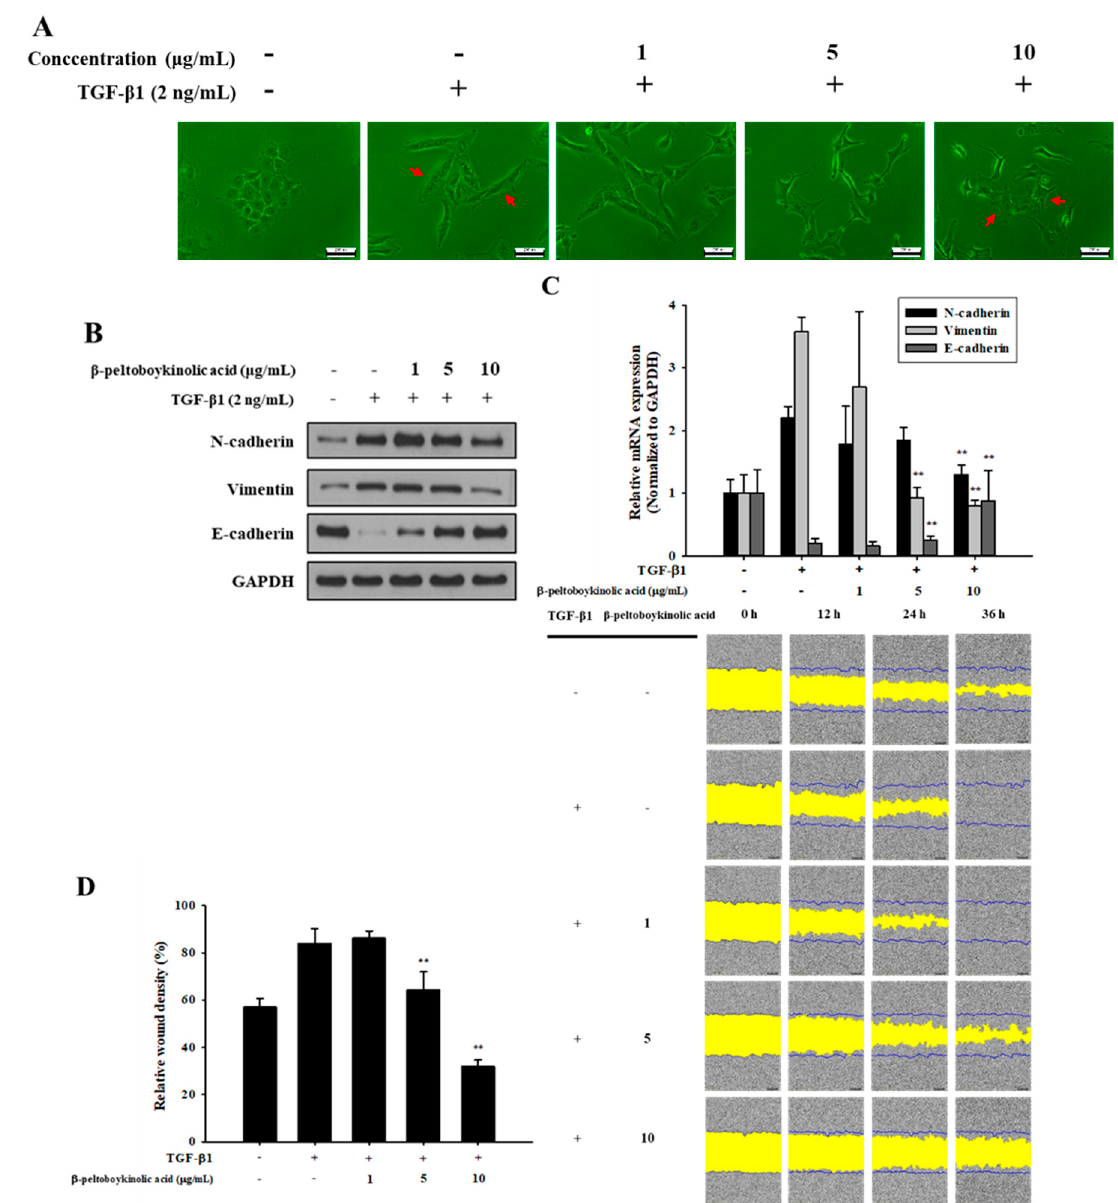
Figure 4. Inhibitory effect of β -peltoboykinolic acid on TGF- β 1-induced epithelial-to-mesenchymal (EMT) in A549 cells. A549 cells were treated with TGF- β 1 or co-treated with β -peltoboykinolic acid for 48 h. ( A ) The morphology of A549 cells was observed using a phase-contrast microscope. Arrows indicate the difference between cell morphologies. Scale bar = 200 μ m. ( B ) The expression of N-cadherin, vimentin, and E-cadherin proteins were analyzed using Western blot analysis, with GAPDH expression used as a loading control. ( C ) A549 cells were treated with TGF- β 1 (2 ng/mL) or co-treated with β -peltoboykinolic acid (1, 5, and 10 μ g/mL) for 24 h. The expression of N-cadherin, vimentin, and E-cadherin mRNA were analyzed using qRT-PCR. Fold change was calculated using 2 - ΔΔ Ct relative quantitative analysis. ( D ) A549 cells were treated with TGF- β 1 (5 ng/mL) or co-treated with β -peltoboykinolic acid (1, 5, and 10 μ g/mL). The cell mobility was analyzed by IncuCyte ZOOM over 36 h at 10× magnification through a phase-contrast objective lens. The bar graph represents the wound density at 24 h exposure. All data are shown as mean ± S.D., n = 3. ** p < 0.01 vs. the TGF- β 1-treated